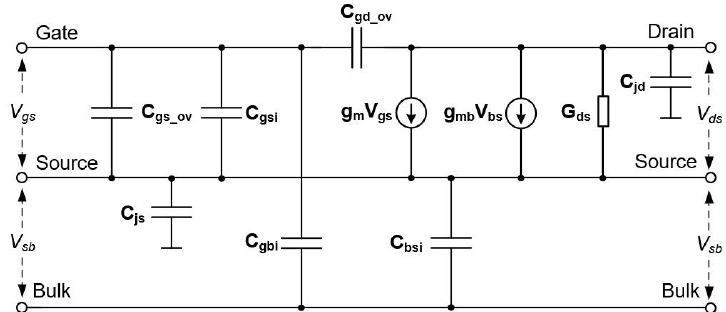
Figure 4. MOS radio frequency (RF) small signal equivalent circuit.